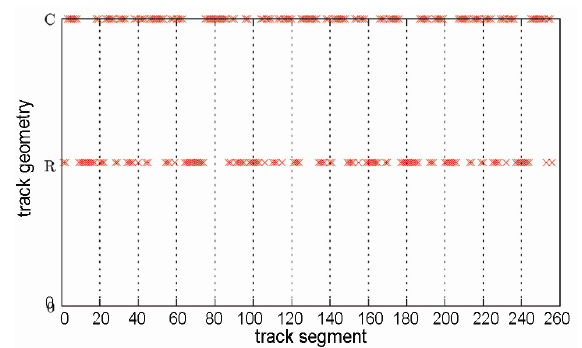
Table 1. Total number of maintenance actions and total